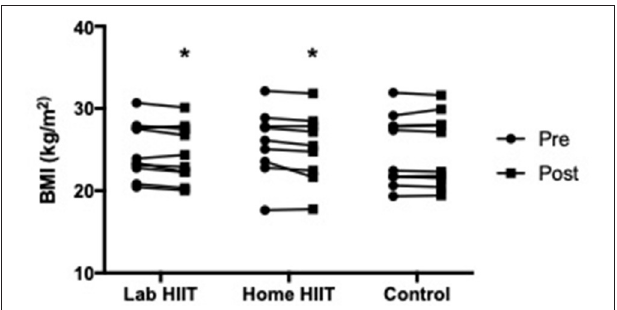
FIGURE 3 | Body mass index (BMI) in young individuals before and after lab ( n = 10) or home-based ( n = 9) high intensity interval training (HIIT) or a no intervention control ( n = 10) period. * p < 0.05 vs.